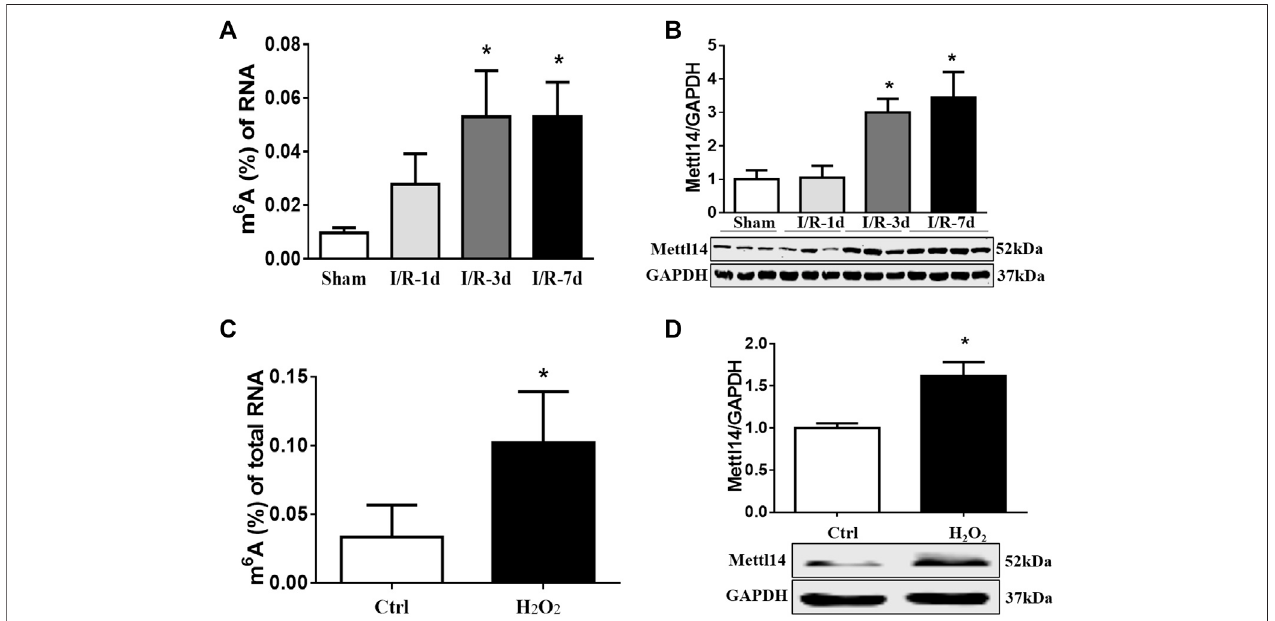
FIGURE 1 | m6A modi fi cation and Mettl14 protein are elevated in heart post-I/R. (A) Enzyme-linked immunosorbent assay (ELISA) detects the level of m6A modi fi cation of RNA at 1, 3, and 7 days after I/R surgery in mice. Sham n (cid:2) 5, I/R-1d n (cid:2) 3, I/R-3d n (cid:2) 4, I/R-7d n (cid:2) 5. * p < 0.05 versus sham. (B) The protein level of Mettl14inischemia – reperfusion(I/R)1,3,and 7 daysand sham-operatedheartswasanalyzed byWestern blotting.Sham n (cid:2) 4,I/R-1d n (cid:2) 4,I/R-3d n (cid:2) 4,I/R-7d n (cid:2) 5. * p < 0.05 versus sham. (C) Detection of the RNA m6A modi fi cation level in cardiomyocytes treated with H 2 O 2 (100 µM) by ELISA. Control n (cid:2) 6, H 2 O 2 n (cid:2) 3. * p